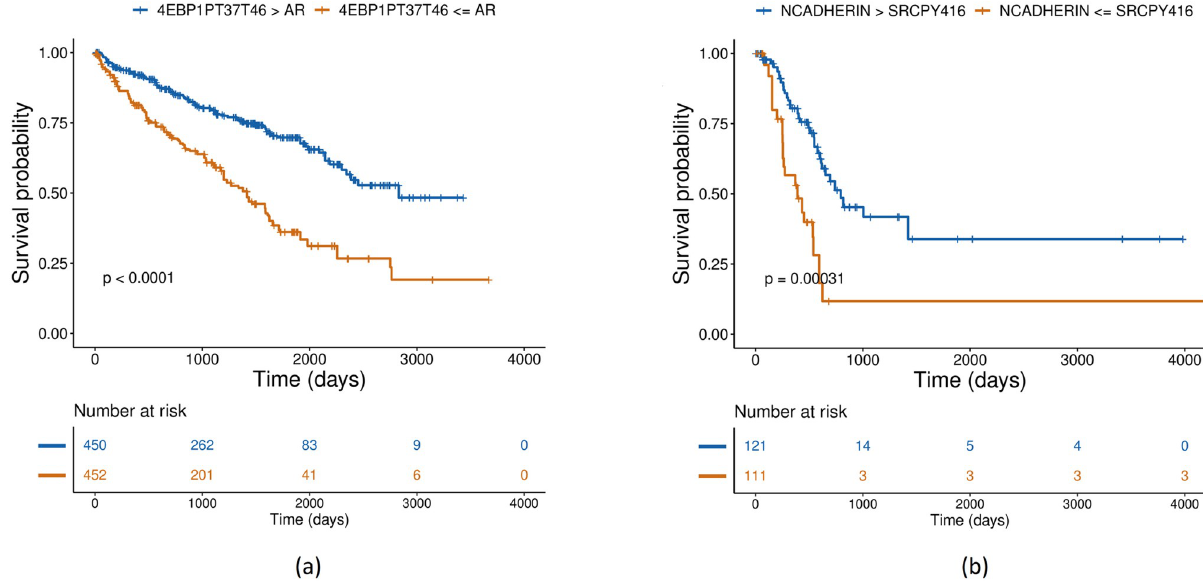
Fig 6. Age and sex adjusted Kaplan-Meier plots for a) KIRC and b) BLCA based on overall survival. Number at risk denotes the number of patients at risk at a given time, and p-value is calculated with the log-rank test.